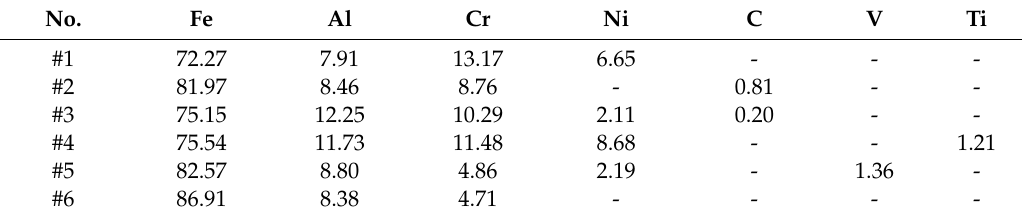
Table 1. Alloy chemical composition (in wt.%) determined by XRF (X-ray Fluorescence, 20 ◦ /